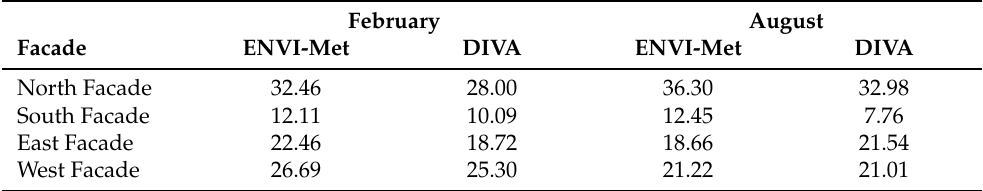
Figure 14. Spatial average irradiance received on the facades in the heterogeneous district in August. Table 6. Normalized root mean squared error of the predicted level of irradiance (%) in the heteroge- neous